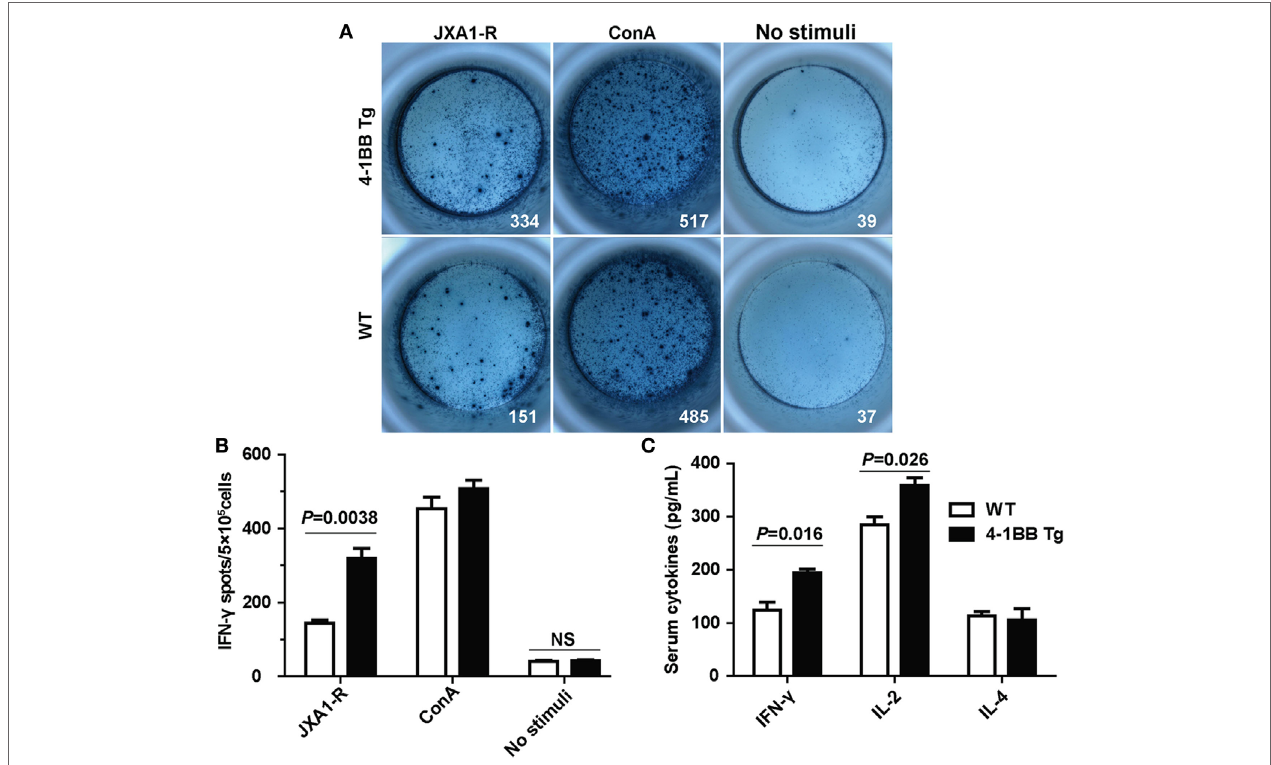
FigUre 6 | Cytokines secretion by peripheral blood lymphocytes in the Enzyme-Linked ImmunoSpot (ELISPOT) and enzyme-linked immunosorbent assay (ELISA) assays. (a) Peripheral blood mononuclear cells (5 × 10 5 cells/well) from transgenic and wild-type pigs were stimulated with PRRSV JXA1-R or ConA for 36 h. Complete RPMI media were used as the unstimulated controls. Samples were tested in triplicates. Images from the plate scan generated by the ImmunoSpot analyzing system are shown. Average numbers of spots per well are indicated. (B) Summary of the spots per well in IFN- γ ELISPOT assay. P < 0.05 was considered statistically significant. (c) Serum concentrations of IL-2, IFN- γ , and IL-4 were measured by ELISA. Each sample was assayed in